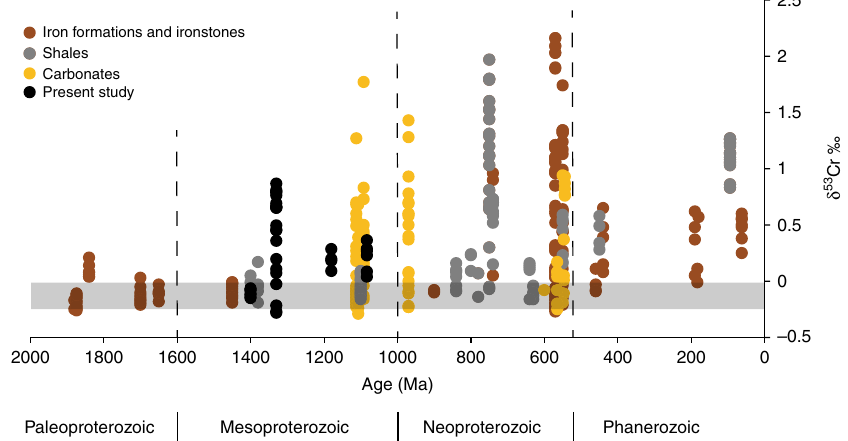
Fig. 8 Compilation of sediment δ 53 Cr values over the last 2000 Ma. The gray horizontal bar in the δ 53 Cr represents the crustal value 39 . All data